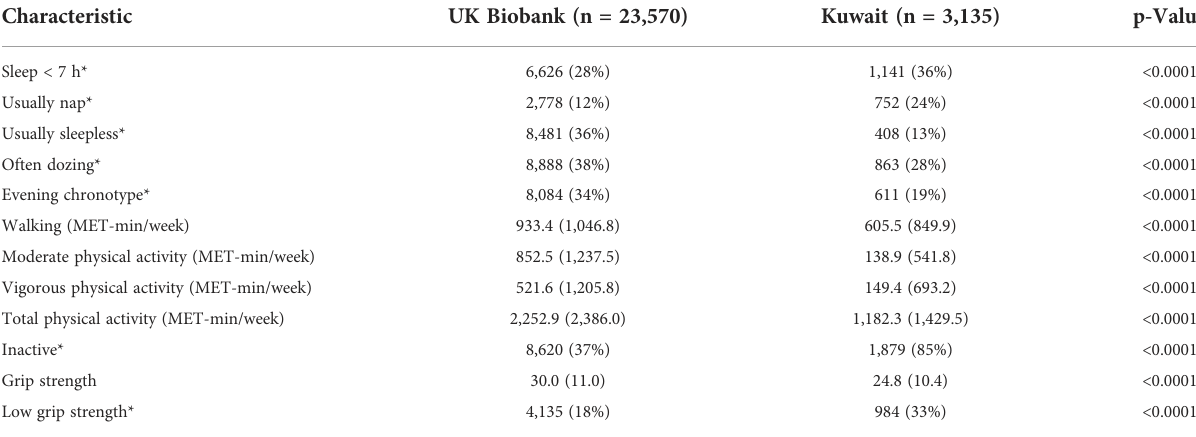
TABLE 2 Physical activity, sleep, and physical function data in UK Biobank and Kuwaiti cohorts of people with type 2 diabetes.